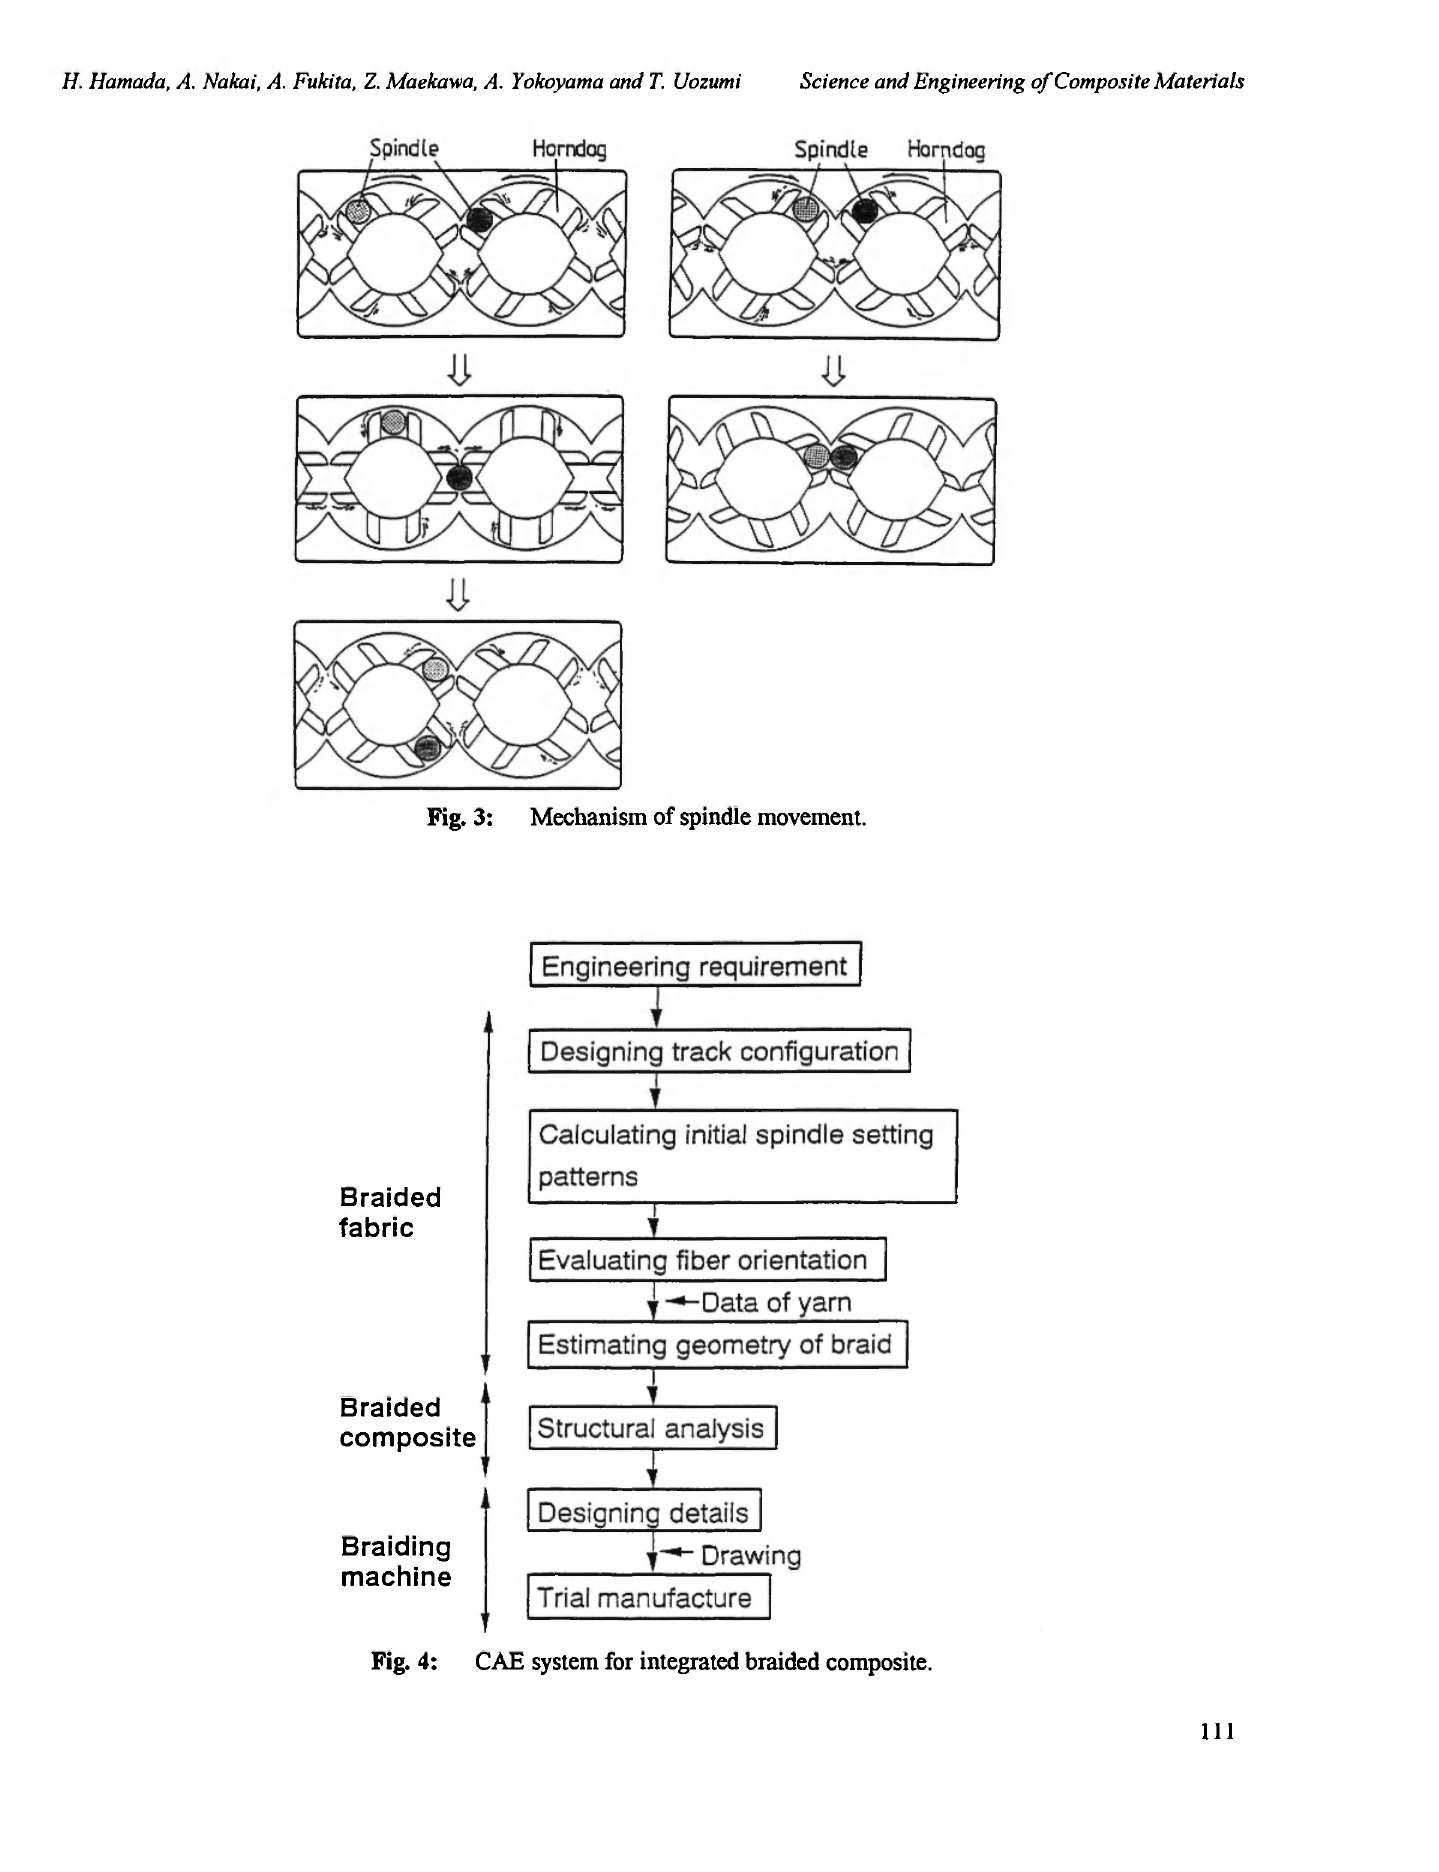
Fig. 4: CAE system for integrated braided